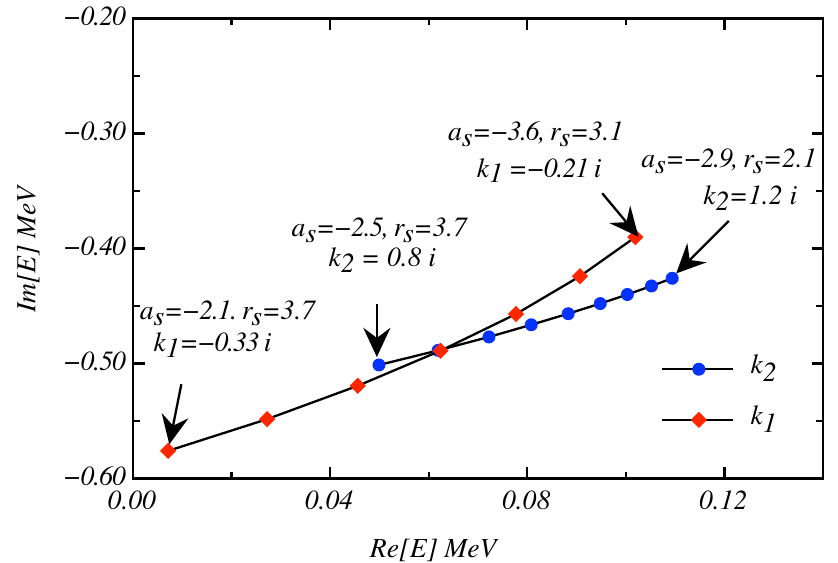
Figure 5: Variation in the position of the Λ nn pole as one varies separately the singlet Λ n pole positions in the effective range amplitude k included in the figure are the singlet effective range parameters a